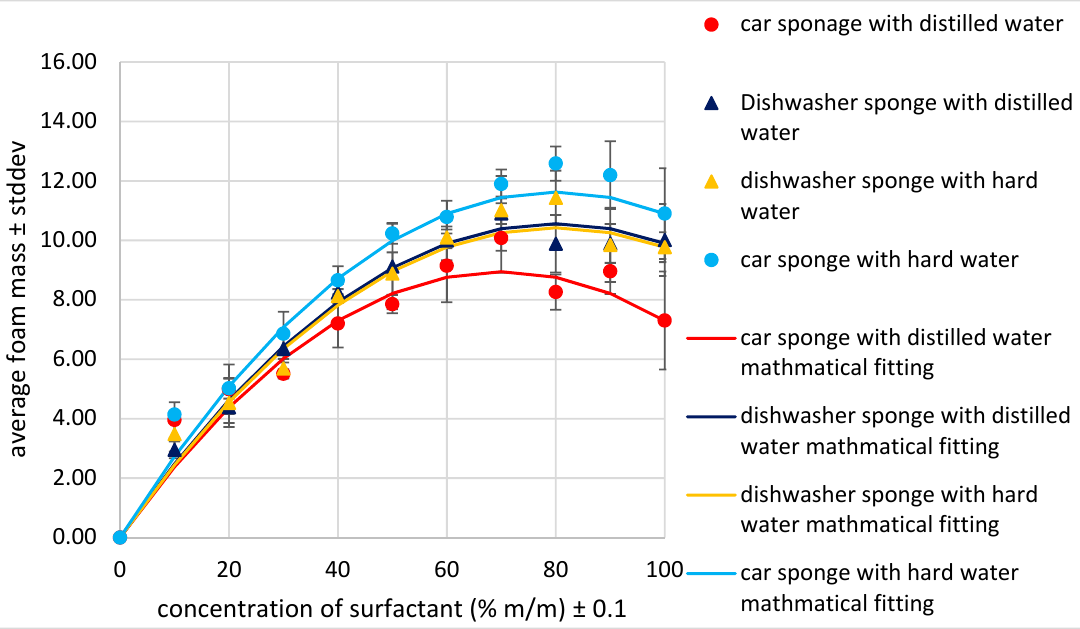
Figure 6. Average total foam mass for both the Dishwasher sponge and the car sponge for each concentration of surfactant. Fitted according to Equation (2), with M min = 7.30 and c max = 0.7 for distilled water with dishwasher sponge, M min = 9.77 and c max =0.8 for hard water with car sponge, M min = 10.01 and c max = 0.7 for distilled water with dishwasher sponge and M min = 10.90 and c max = 0.8 for hard water with car sponge [8].